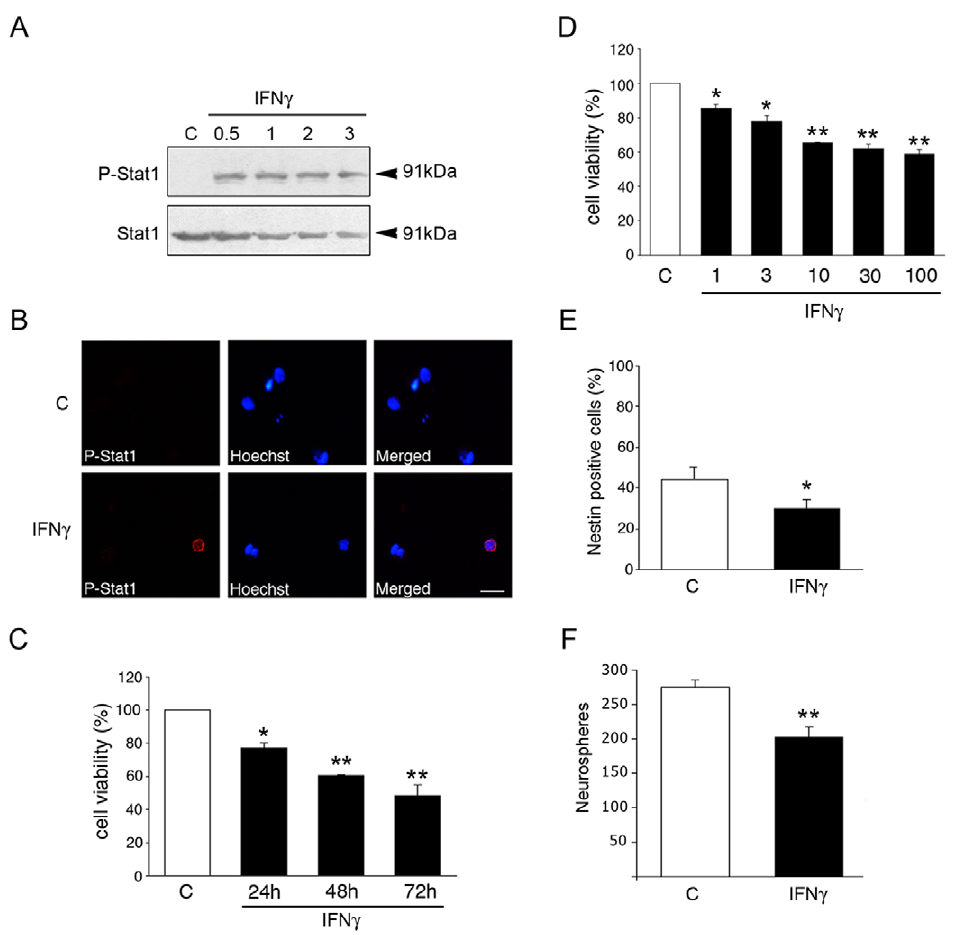
Figure 2. IFN c activates STAT signaling and decreases cell viability of NPCs. NPCs were treated with 100 ng/ml IFN c for different times and analyzed as described in Methods. *p , 0.05 and **p , 0.001 comparing IFN c treated vs. controls. ( A ) Immunoblot shows increased levels of phospho- STAT1 (p-Stat1) after 0.5 h. ( B ) Immunostaining showed the presence of p-Stat1 in the nucleus after 2 h treatment. Scale bar, 10 m m. ( C ) Cell viability was determined by the MTT assay as described in Methods. Values are means 6 SD, n=4. ( D ) Dose response curve. Cells were treated for 48 h and cell viability determined. Values are means 6 SD, n=4. ( E ) Cells were treated for 48 h and the number of nestin positive NPCs was analyzed. Values are means 6 SD, n=4. ( F ) Neurospheres were dissociated and about 5000 cells per well were incubated for 3days in absence or presence of 100 ng/ ml IFN c . The number of secondary neurospheres formed was counted. Values are means 6 SD, n=4.